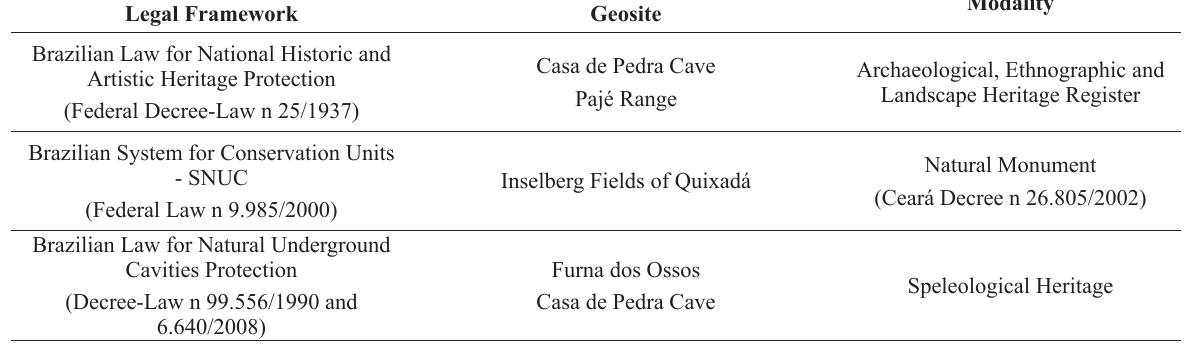
Geosites protected according to Brazilian legal